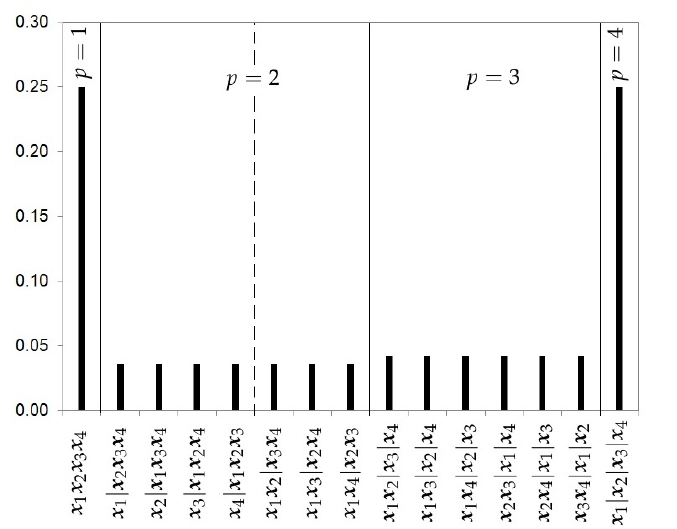
Figure 3. Hierarchical Uniform prior with 2 levels probabilities for the partitions with k = 4